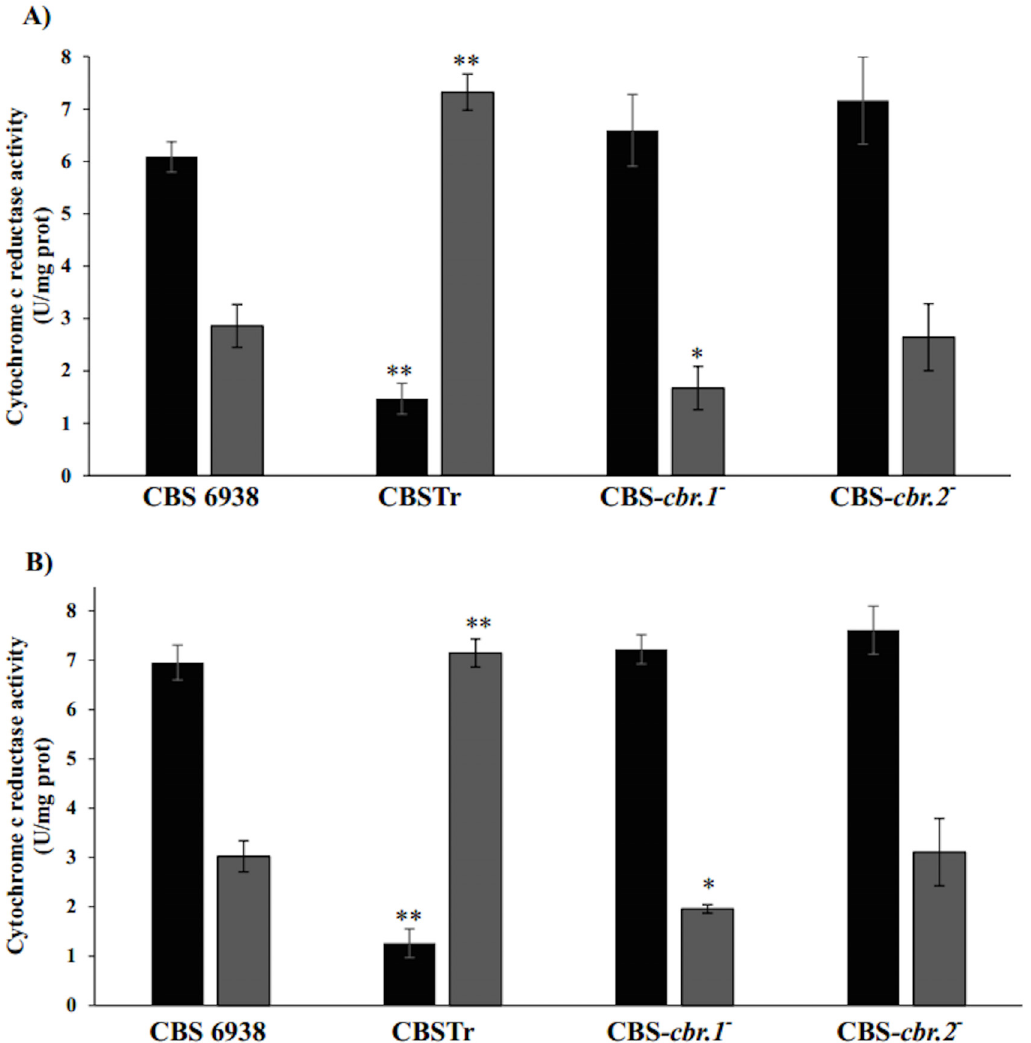
Fig 5. Cytochrome c reductase activity of the wild-type and mutant strains. Assays were performed with NADPH (black bars) or NADH (grey bars) as cofactor using microsomal fractions extracted after (A) 36 h and (B) 72 h of culture. Values are the mean ± standard deviation of two technical replicates from three independent cultures. Statistical significant differences between wild-type and mutant strain compared to the same assay are indicated (Student ’ s t test, * P < 0.05, ** P < 0.01 with α = 0.05).